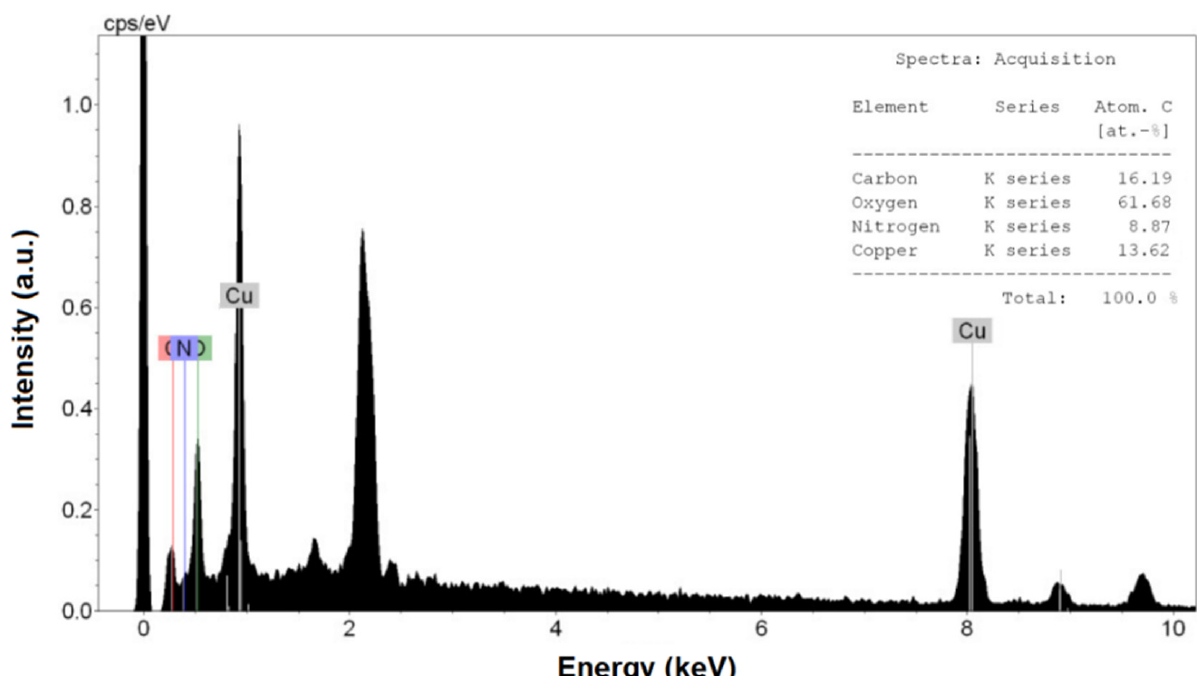
Figure 4. EDS of chitosan-CuO nanocomposites (15 wt.%).